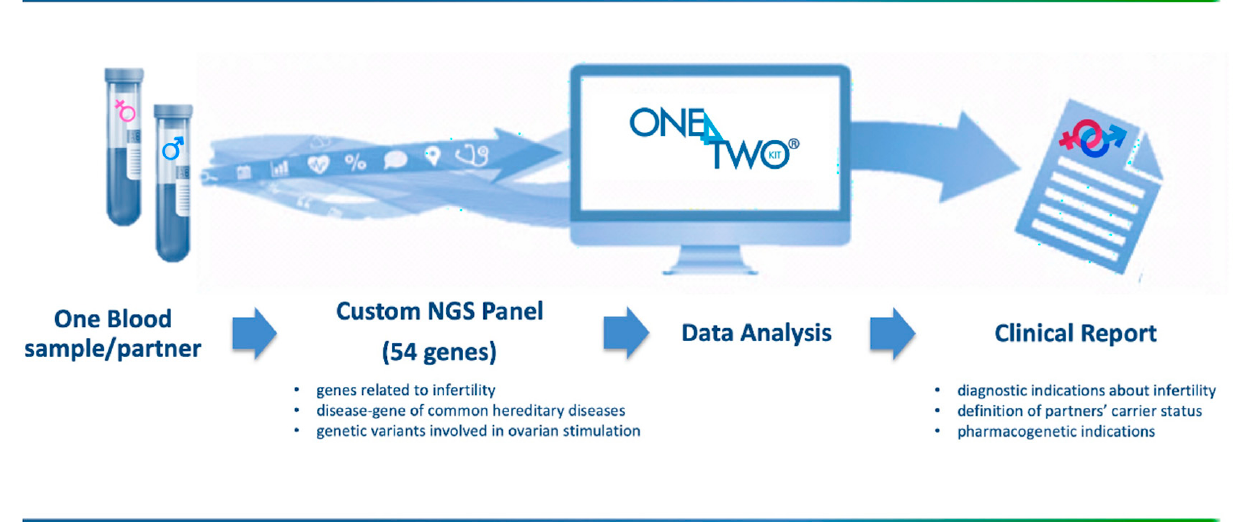
Figure 1. One4Two ® key points. This custom genes panel has been designed to simplify the diagnostic path of infertile Figure 1. One4Two  key points. This custom genes panel has been designed to simplify the diag- couples: starting from just one blood sample/partner it allows the simultaneous analyses of a set of 54 genes providing data related to the genetic causes of infertility, partners’ carrier status of some of the most common inherited diseases, and also responsiveness to hormonal treatments. Indeed, patients have to undergo a single investigation, laboratories have to manage a single workflow, and reproduction specialists obtain relevant information in a single report tailored for each